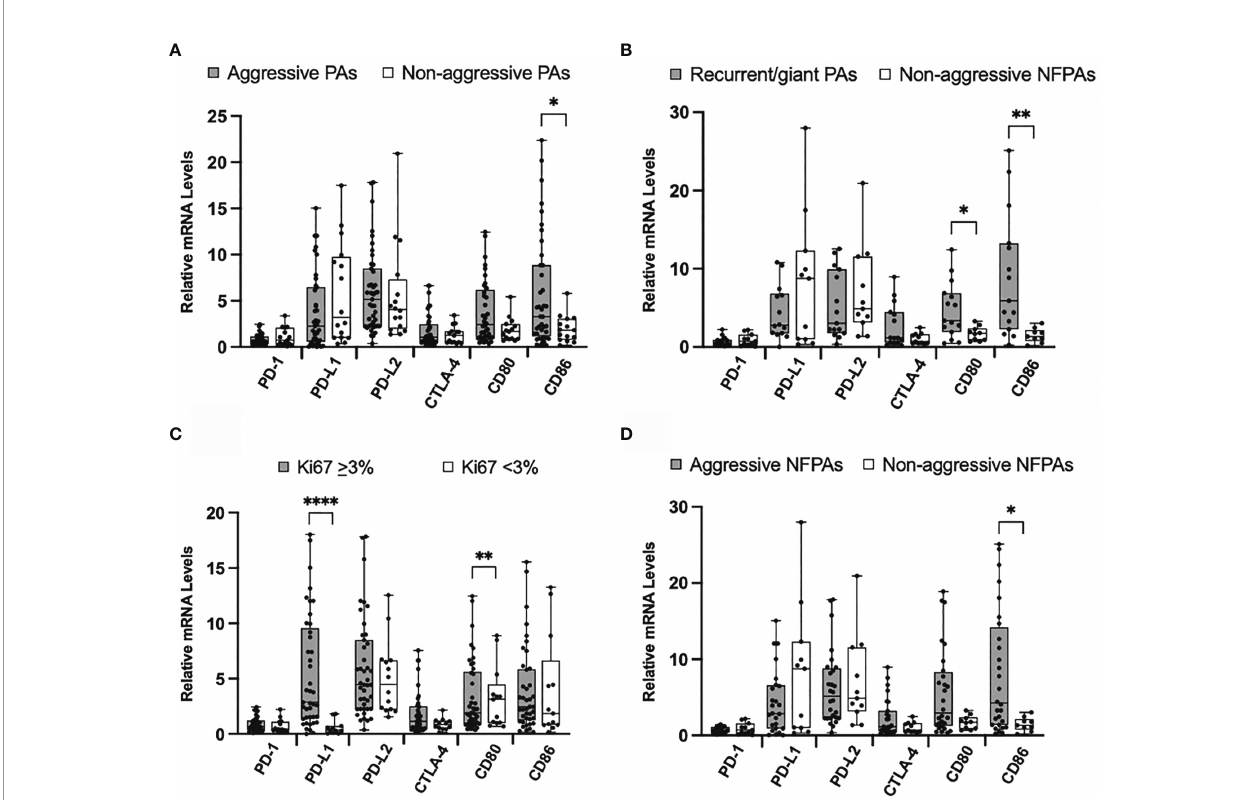
FIGURE 2 | Immune checkpoint molecule mRNA expression in aggressive PAs compared to non-aggressive PAs. (A) Comparison of relative mRNA levels of immune checkpoint molecules between all aggressive PAs (gray) and all non-aggressive PAs (white). (B) Comparison of relative mRNA levels of immune checkpoint molecules between PAs recurrent through radiation or giant, invasive on presentation (gray) compared to non-functioning non-aggressive PAs (white). (C) Comparison of relative mRNA levels of immune checkpoint molecules between PAs with Ki67 ≥ 3% (gray) and PAs with Ki67 < 3% (white). (D) Comparison of relative mRNA levels of immune checkpoint molecules between non-functioning aggressive PAs (gray) and non-functioning non-aggressive PAs (white). * p < 0.05; ** p < 0.01; **** p <